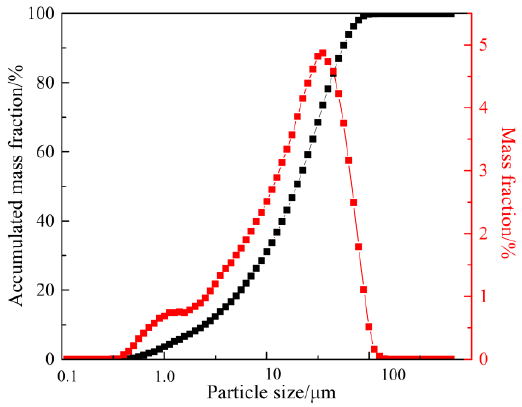
Figure 3. Particle size distribution of cyanide tailings.